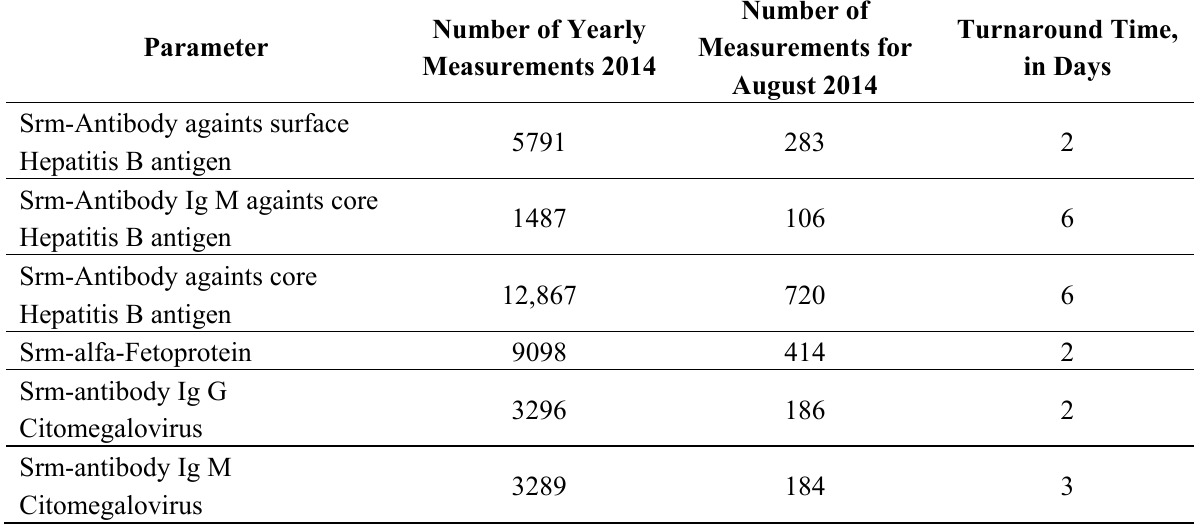
Table 1. Measurements performed in the two analytical modules during 2014 and the goal turnaround times that the laboratory promised to